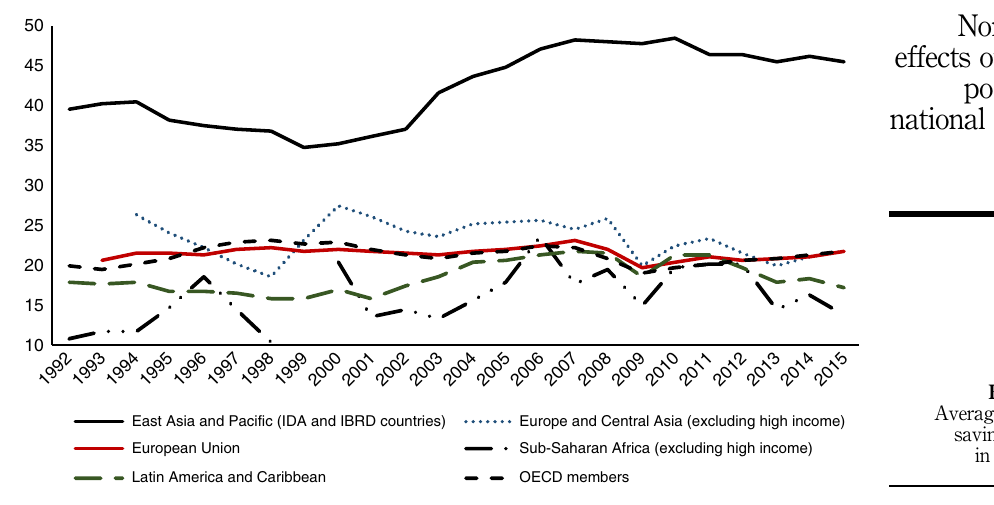
Figure 1. Average